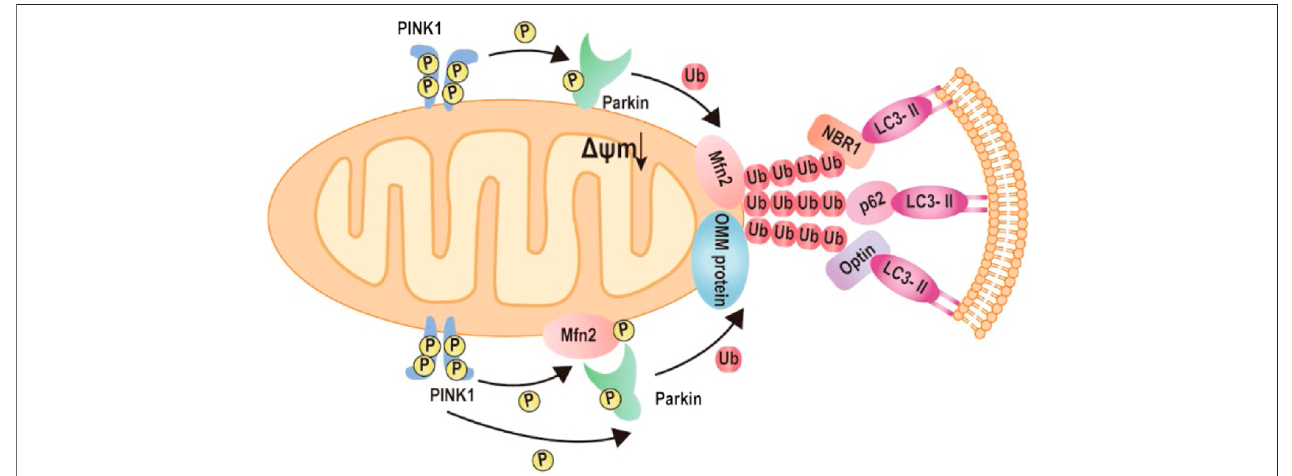
FIGURE 4| Mechanism of Mfn2-mediated mitophagy. 1) Upon mitochondrial depolarization, the kinase PINK1 accumulates at the mitochondrial outer membrane and initiates phosphorylation and recruitment of Parkin. Activated Parkin ubiquitylates Mfn2. The formation of ubiquitin chains on mitochondrial surface proteins promotes its binding to LC3-II via the mitochondrial receptors such as optineurin, NBR, or p62. 2) Upon mitochondrial depolarization, accumulation of kinase PINK1 phosphorylates Mfn2, which recruits Parkin to the mitochondrial outer membrane. Parkin phosphorylated by PKIN1 ubiquitylates several outer mitochondrial membrane proteins. The formation of ubiquitin chains on mitochondrial surface proteins promotes its binding to LC3-II via the mitochondrial receptors such as optineurin, NBR, or